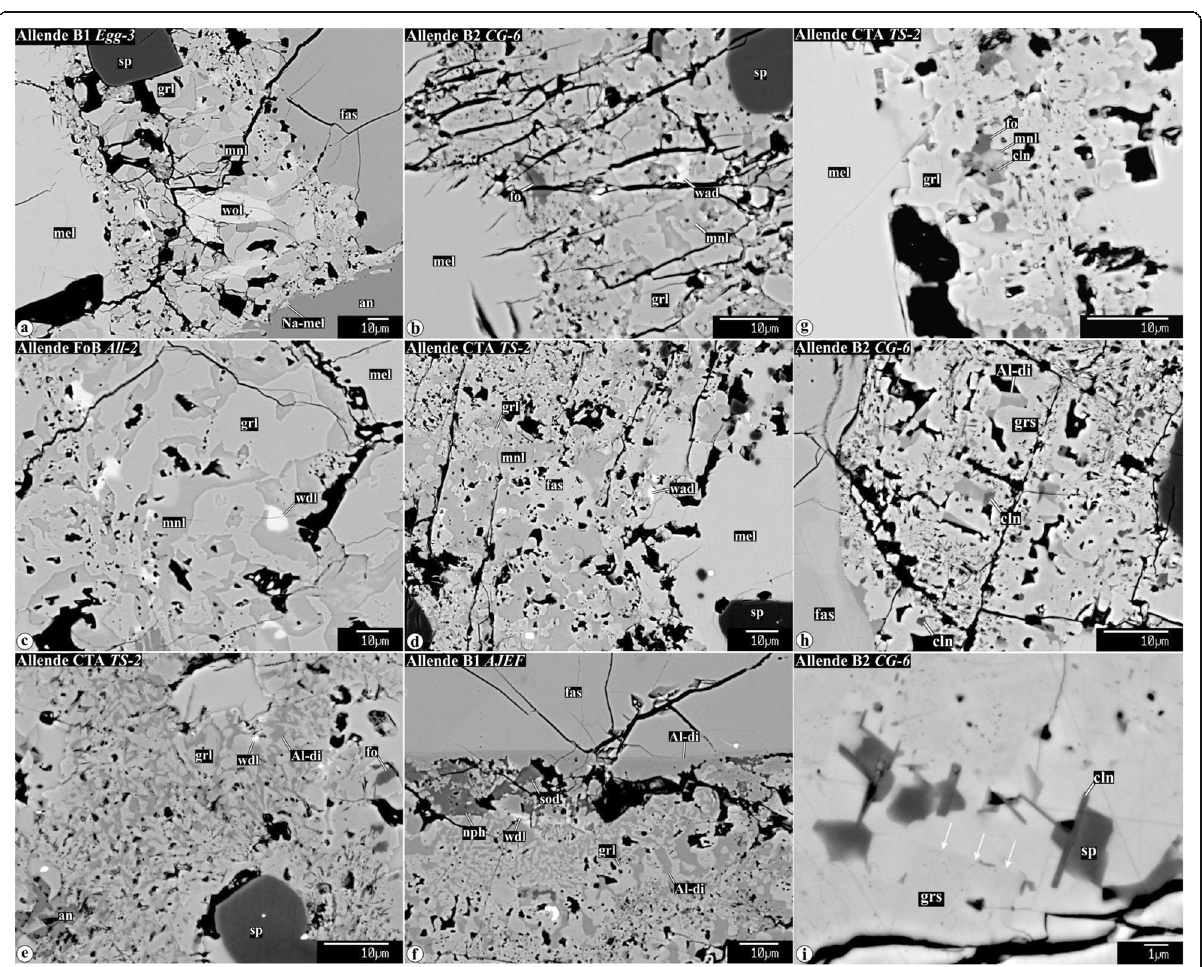
Fig. 4 Backscattered electron images of secondary mineral assemblages replacing åkermanitic melilite in Type B1, B2, FoB, and CTA CAIs: a grossular-monticellite-wollastonite, b − d grossular-monticellite, and e , f grossular-Al-diopside. All these mineral assemblages may contain minor clintonite, forsterite, spinel, Na-melilite, and wadalite. Na-melilite is commonly observed at the boundary between altered melilite and igneous anorthite (see a ). Arrows in i indicate a boundary between grossulars with different MgO contents (dark, 3.7 and light, 2.3